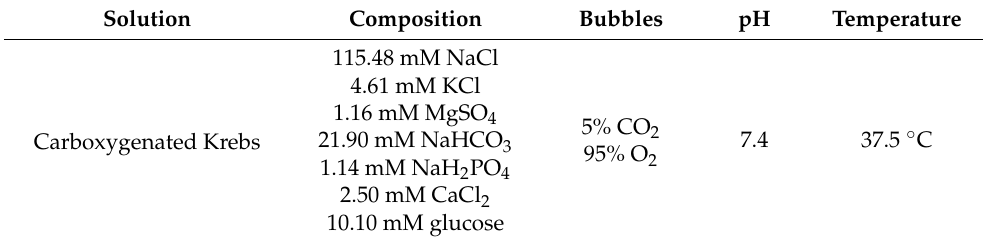
Table 2. Composition of the carboxygenated Krebs–Ringer solution.